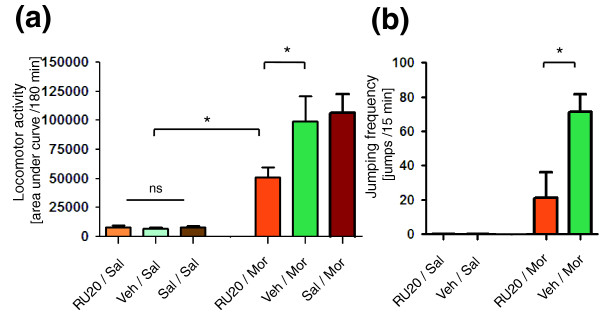
Modulation of behavioral response to morphine by RU486 pretreatment. (a) Effects of acute morphine administration (20 mg/kg, subcutaneously) on locomotor activity were analyzed in glucocorticoid antagonist-treated C57BL/6J mice. Mice were injected with 20 mg/kg RU486 (RU20). After 30 min, the mice were injected with morphine (Mor) or saline (Sal). Column bars correspond to the mean number of photocell counts per group with standard error (n = 6 to 8) collected from 0 to 180 min after administration of morphine. (b) Influence of glucocorticoid receptor antagonist pretreatment on the development of opioid physical dependence was analyzed in C57BL/6J mice. RU486 (20 mg/kg) was administered 30 min before acute injection of morphine (100 mg/kg, subcutaneously). The next day animals were injected with an additional dose of morphine (20 mg/kg, subcutaneously) following by the injection of naloxone (15 mg/kg, subcutaneously). The level of morphine dependence is presented as mean naloxone-precipitated withdrawal jumping response (number of jumps per 30 min after naloxone injection) with standard error (n = 5 to 6). Control animals were treated with vehicle (Veh) and saline (Sal). The data presented in panels a and b were analyzed using analysis of variance following Tukey's post hoc test (*P < 0.05; ns, not significant).